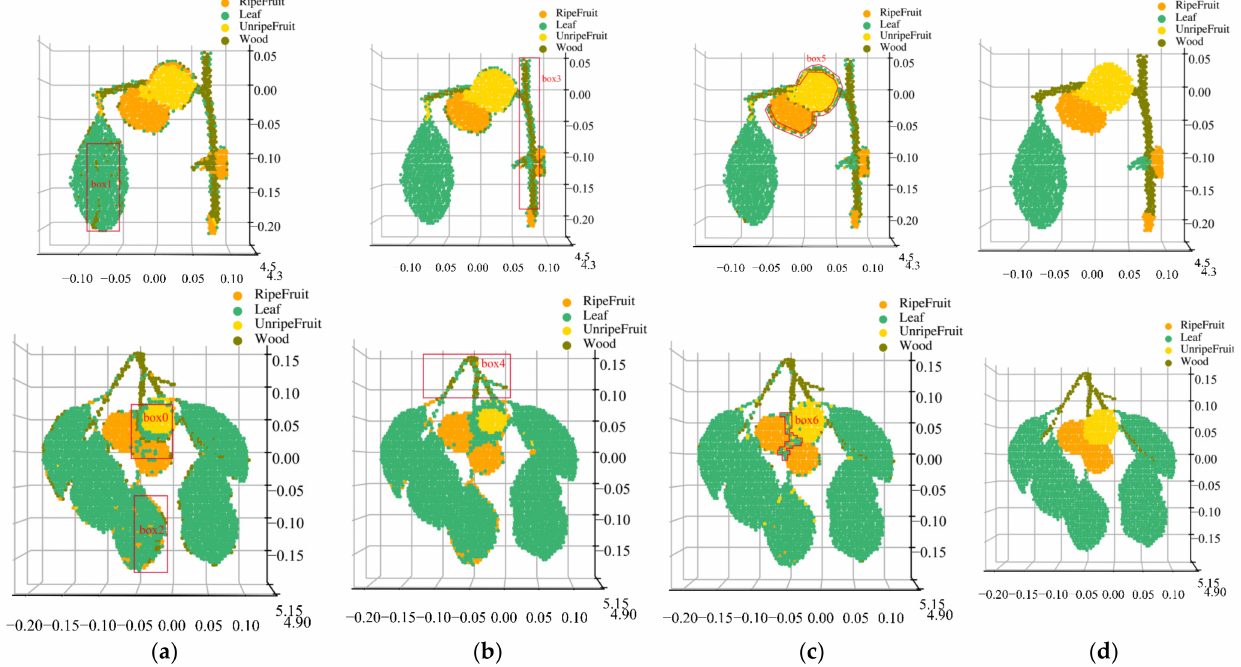
Figure 7. Three-dimensional reconstruction of the preliminary classification of the persimmon sample. ( a ) Support vector machine classifier; ( b ) backpropagation neural network classifier; ( c ) random forest classifier; ( d ) real class labels of the persimmon